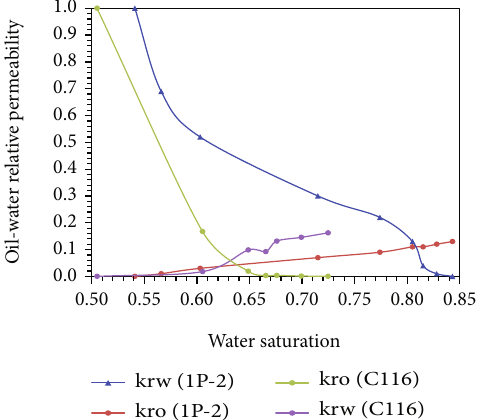
Figure 8: Comparison of oil-water relative permeability curves of di ff erent cores considering nonlinear seepage